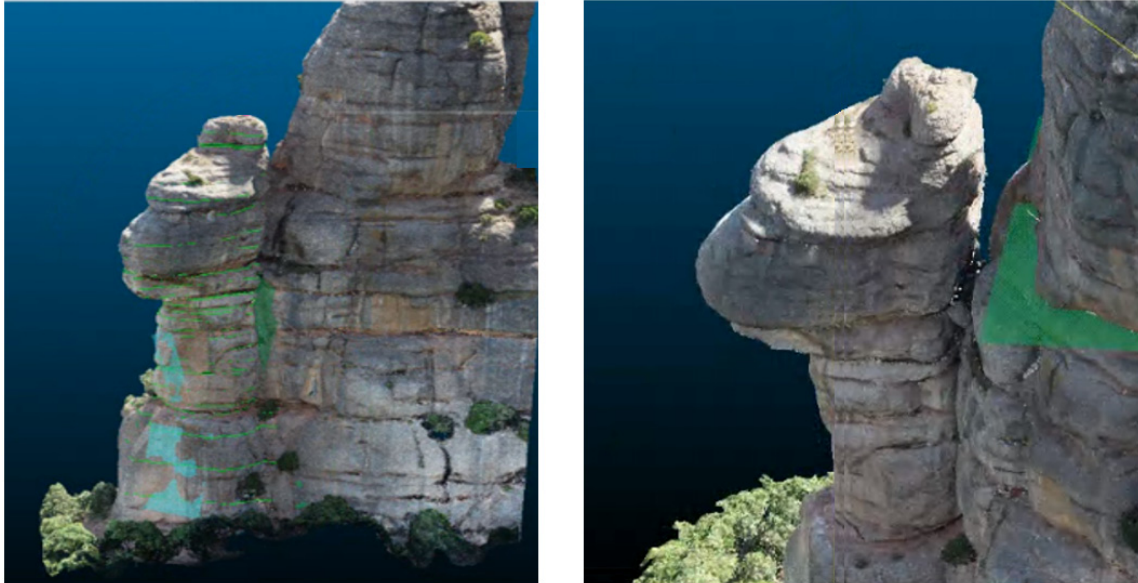
Figure 19. Two perspectives of the “Cadireta” conglomerate block (Montserrat, Agulles area). The block under study is on the left, separated from the massif by a vertical penetrating joint. Some planes in light green were added to the geometry prior to the FEM mesh generation. The 3D model was built using a drone and digital photogrammetry software, and is viewed with CloudCompare [60].